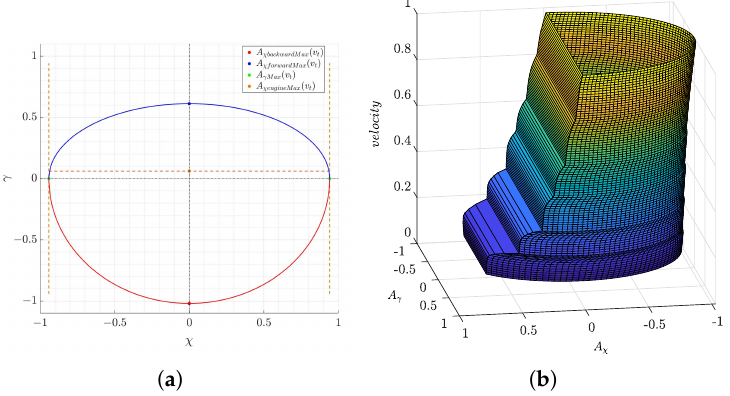
Figure 4. Single GG diagram of the vehicle and its change with the vehicle speed. ( a ) Approx- imation method for the g-g diagram: two half ellipses for tire limits and a line for engine limit. ( b ) Autonomous driving car GG-V diagram, evaluated through simulation